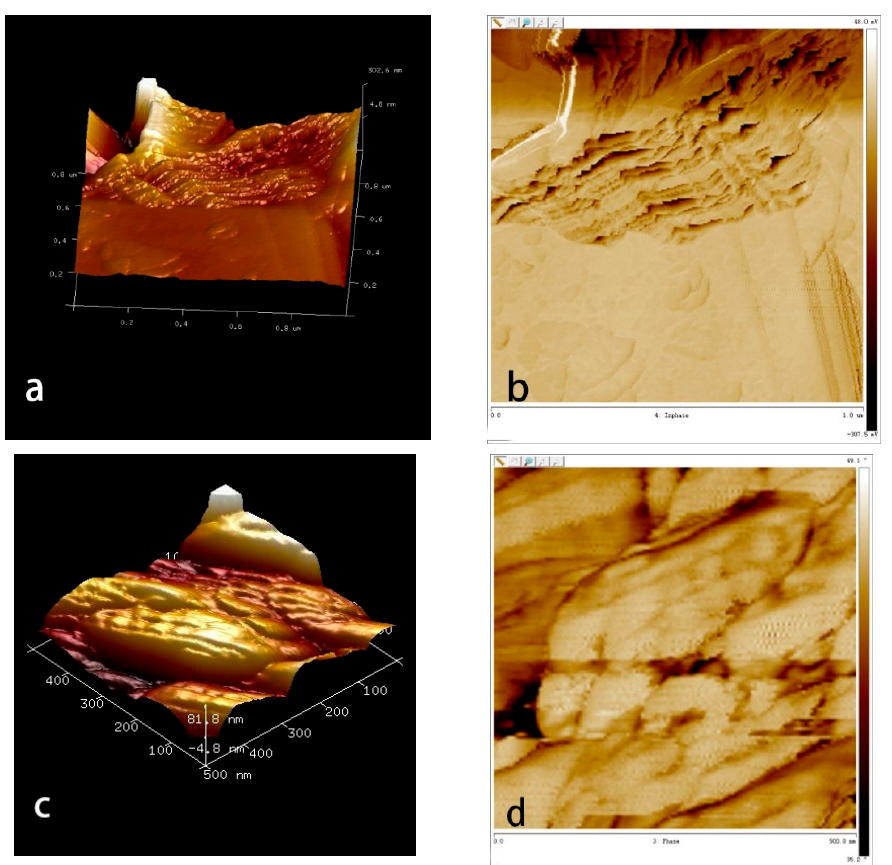
Figure 15. Appearance of GNPs ( a , b ) and GOs-SH ( c , d ) analyzed by AFM.